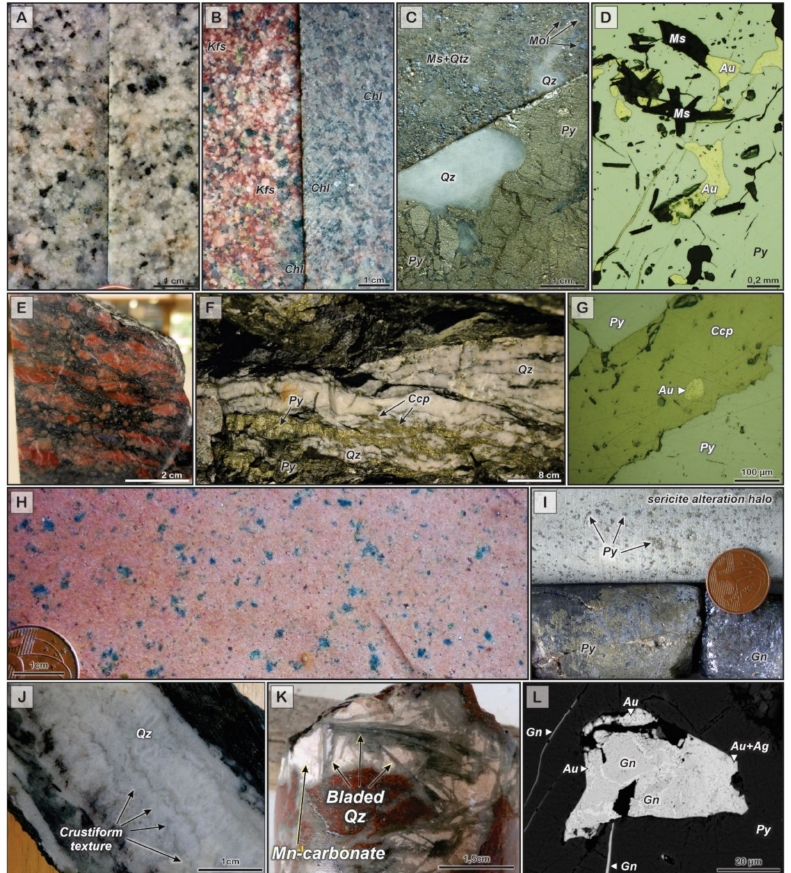
Figure 7. Major features concerning the gold deposits and occurrences from the Juruena Mineral Province. ( A ) Host rock of tonalitic–granodioritic composition from the X1 and P é Quente deposits; ( B ) The inner area related to the granite-hosted systems are represented by pervasive potassic (K-feldspar–quartz–hematite) alteration, whereas the outer and more regional alteration halo is composed of propylitic chloritic alteration (chlorite–epidote–calcite); ( C ) Ore-shoots are mainly related to muscovite–quartz–pyrite alteration, with minor amounts of chalcopyrite and molybdenite; ( D ) Gold as inclusions in pyrite or filling its fractures; ( E ) Orthogneisses with pervasive potassic (K-feldspar) alteration, often observed in the vein-hosted deposits; ( F ) Quartz ± carbonate veins with pyrite- and chalcopyrite-bearing gold; ( G ) Gold inclusion in chalcopyrite in the Para í ba vein- hosted gold deposit; ( H ) Porphyries of granodioritic to tonalitic composition, which host several gold deposits and occurrences; ( I ) Pyrite–galena veins with sericite alteration halo from the Francisco epithermal gold deposit; ( J ) Crustiform texture in epithermal vein; ( K ) Bladed quartz and Mn- carbonate–quartz veins from the Luiz epithermal occurrence; ( L ) galena–gold–silver inclusion in pyrite from the Francisco epithermal occurrence. Mineral Abbreviation after